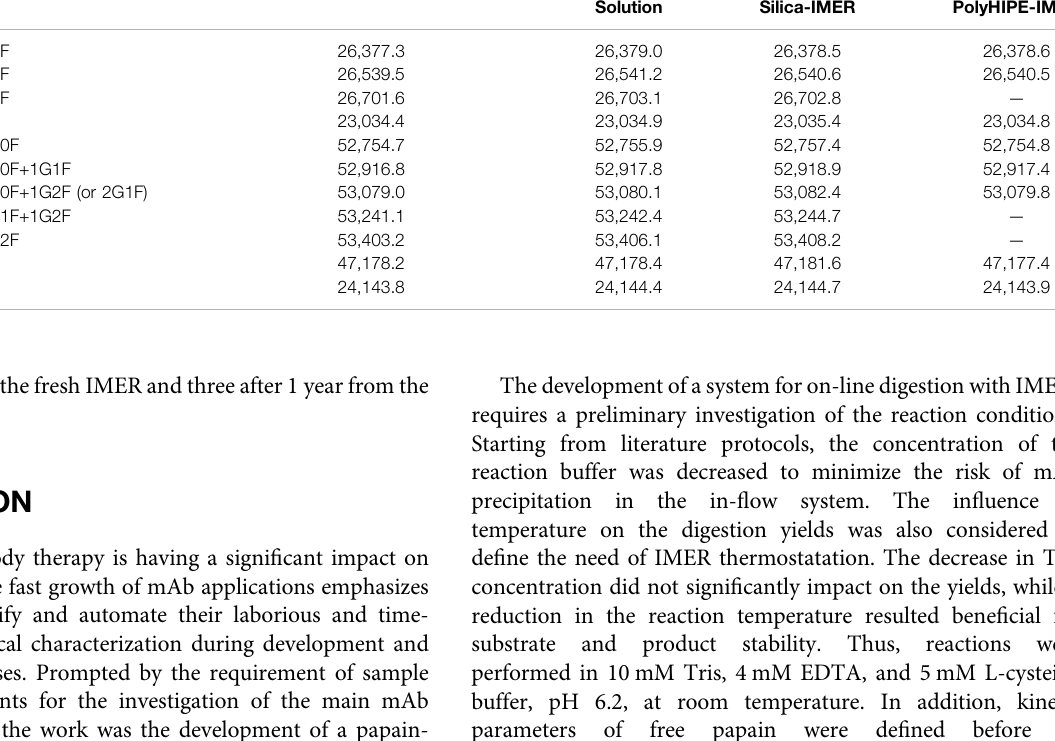
TABLE 6 | Assigned mAb fragments in LC-MS analyses of RTX digested by papain in solution and in the silica- and polyHIPE-IMERs. -K (cid:2) cleaved C-terminal lysine; p (cid:2) N-terminal pyroglutamate modi fi cation. Fragment